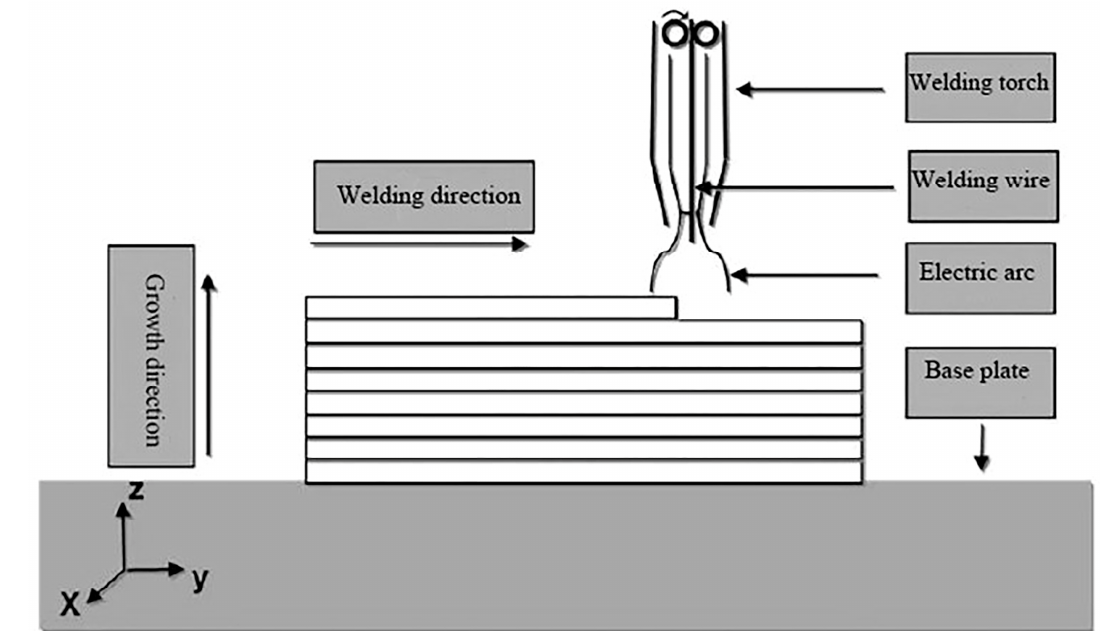
Figure 2. Schematic diagram of wire–arc additive-manufacturing principle.